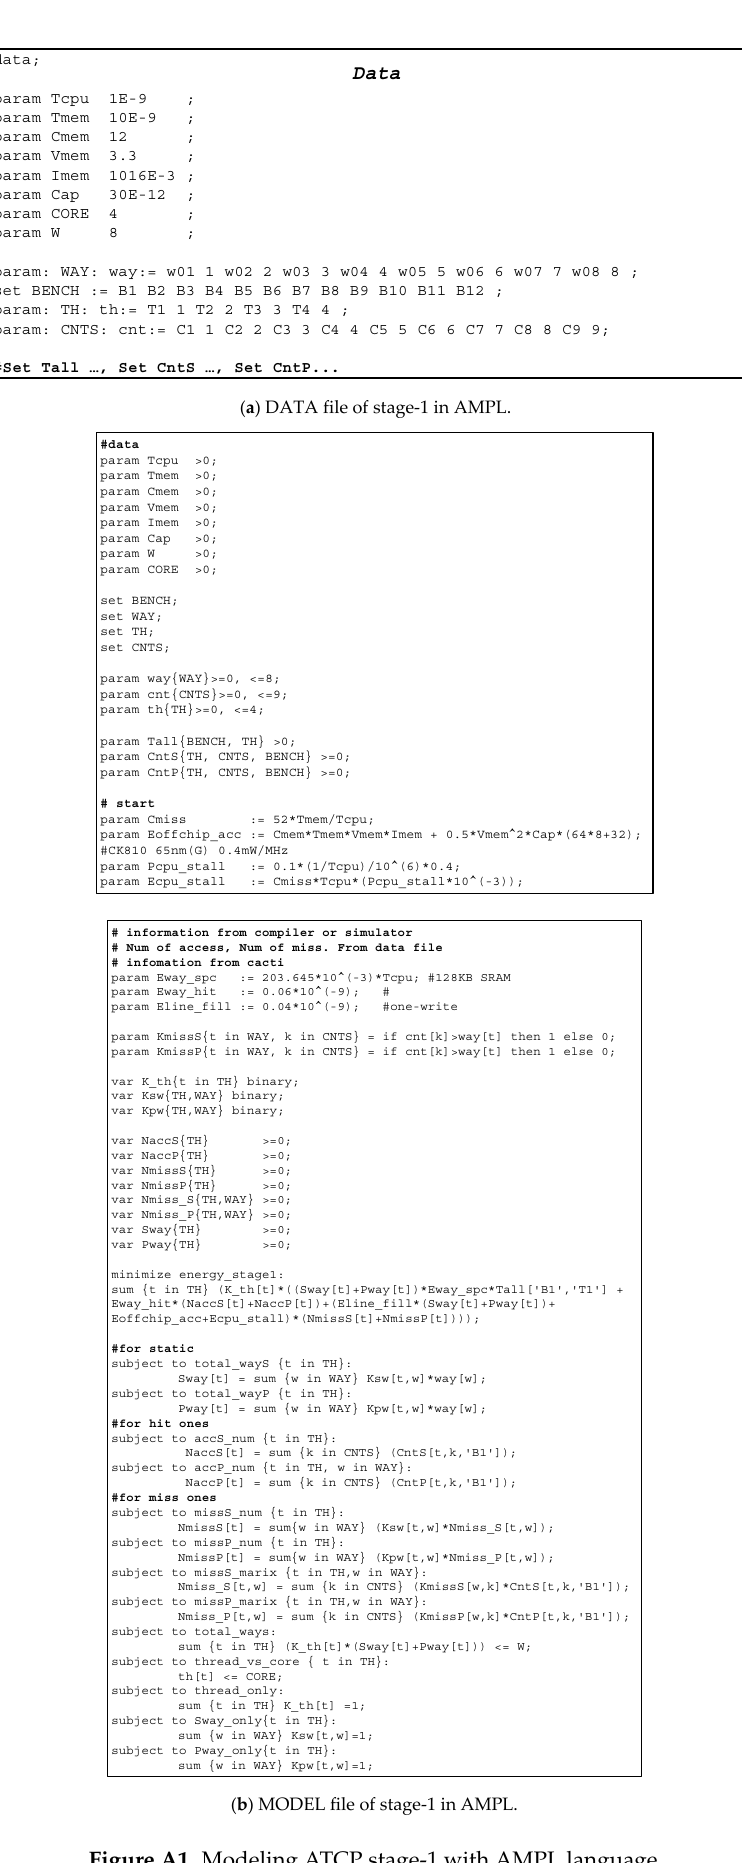
Figure A1. Modeling ATCP stage-1 with AMPL language.